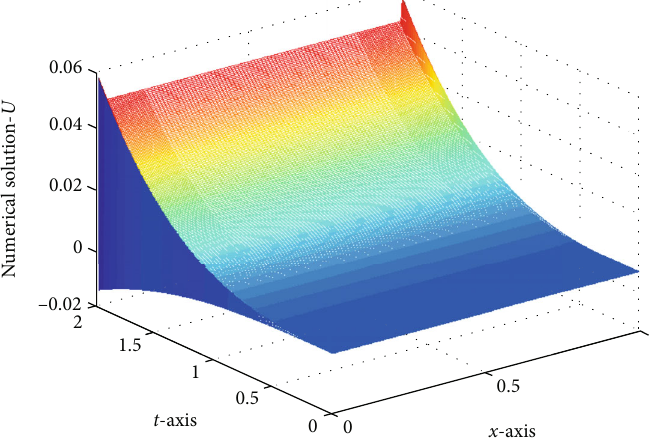
Figure 3: Numerical simulation at N = 2 7 , Δ t = 0 : 1/2 4 , ε = 2 − 12 , λ = 0